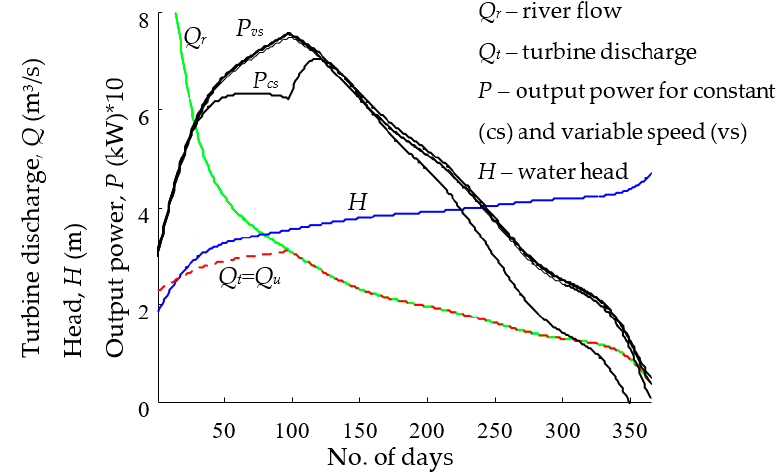
Figure 13. Annual performance curves: river flow ( Q r ), turbine discharge ( Q t ), output power for constant ( P cs ) and variable speed ( P vs ).